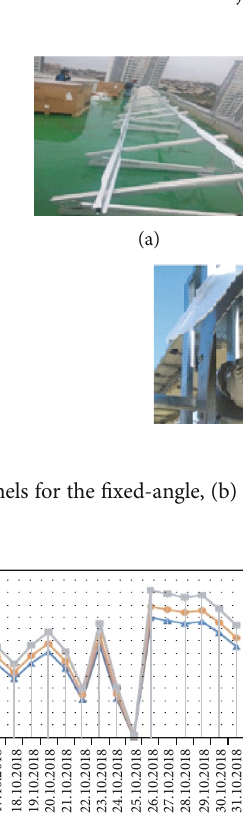
Figure 4: Project installation stages.